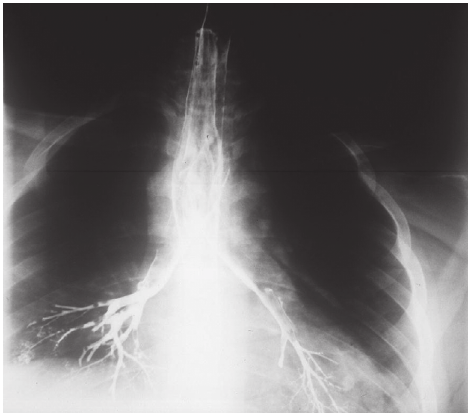
Figure 3 - Esophagotracheal fistula due to blunt trauma. Note contrast medium (barium) in the